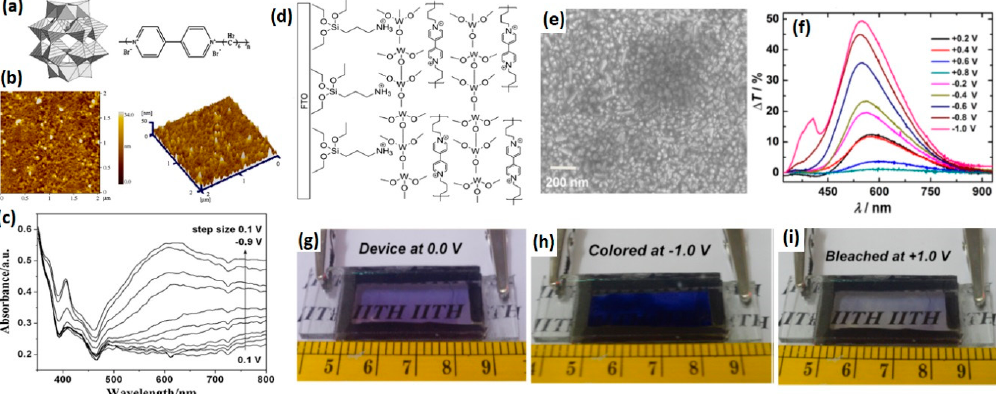
Figure 17. ( a ) The structure of tungsten phosphate (left) and PXV (right). ( b ) AFM images of a [P 2 W 18 / PXV] 5 multilayer film on a silicon wafer. ( c ) Spectroelectrochemistry of [P 2 W 18 / PXV]